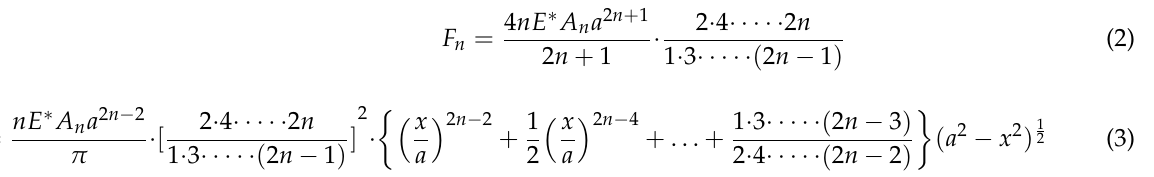
Figure 4. Sketch for analyzing the conformal contact joint with clearance. For two-dimensional axisymmetric shapes in the form of A n x 2 n , the total load function and its pressure distribution curve are obtained